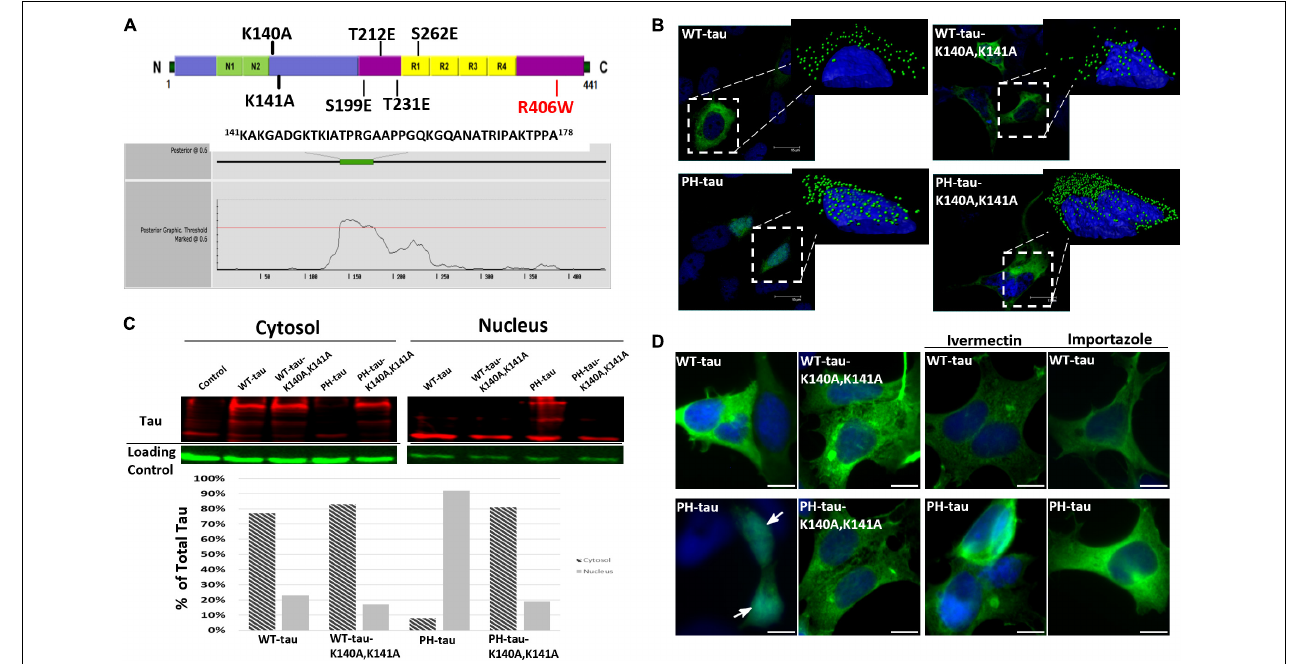
FIGURE 1 | PH-tau translocates into the nucleus via the classical importin- α /importin- β pathway. (A) (Top) Diagram showing the locations of various mutations that were made to either simulate phosphorylation (S199E/T212E/T231E/S262E) or interrupt a putative nuclear localization signal (K140A/K141A). The R406W mutation is a common mutation found in frontotemporal dementia. (Bottom) Output from the NLStradamus prediction software, indicating its prediction of an NLS between amino acids 141 and 178. (B) HEK-293 cells were transfected with WT-tau, PH-tau, WT-tau-K140A,K141A, or PH-tau-K140A,K141A. Images are 63X magnification. (Insets) 3D reconstructions of individual tau-expressing cells were generated using IMARIS software to better visualize the nuclear localization of tau (green dots). Interruption of the putative NLS by mutation changes this localization. (C) Cytoplasmic and nuclear fraction from tau-transfected cells were separated by SDS-PAGE and stained for tau and loading controls (GAPDH for cytoplasm and Histone H3 for nucleus). These data confirm the microscopic visualization of PH-tau primarily in the nucleus and of PH-tau-K140A,K141A primarily in the cytoplasm. (D) Transfected cells were incubated with the importin- α inhibitor ivermectin, the importin- β inhibitor importazole, or in drug-free conditions. PH-tau, but not WT-tau, translocates into the nucleus (arrow). Inhibition of either importin is sufficient to prevent nuclear translocation of PH-tau. Scale bar indicates 15 µ